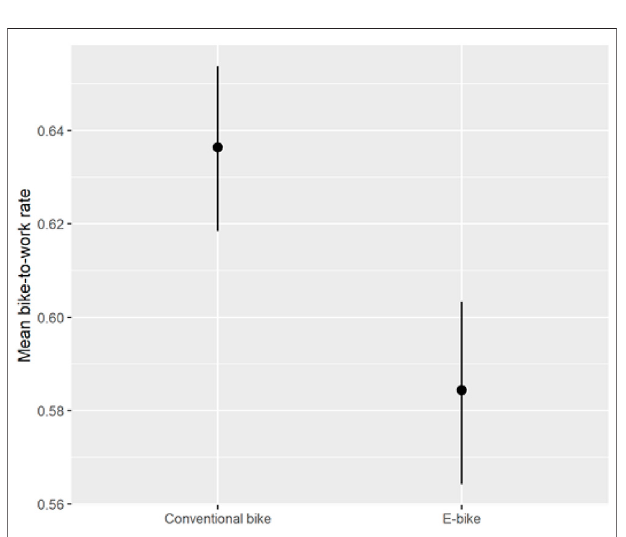
FIGURE 7 | Model predicted mean bike-to-work rate of bike-lending participants by bike type.